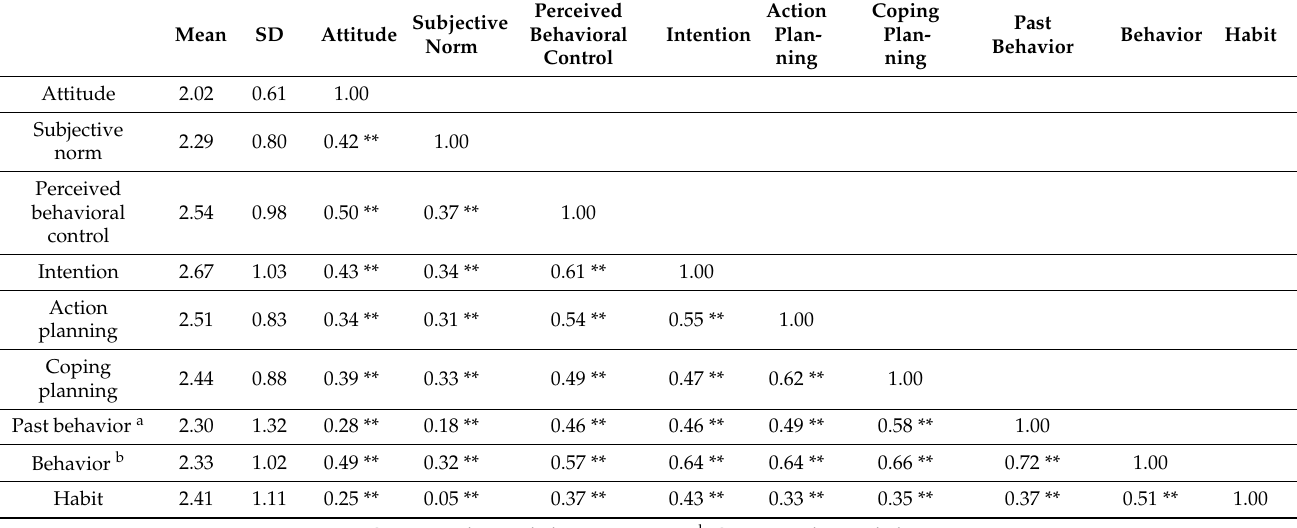
Table 2. Pearson Product Correlation Matrix among Study Variables (N = 1822).